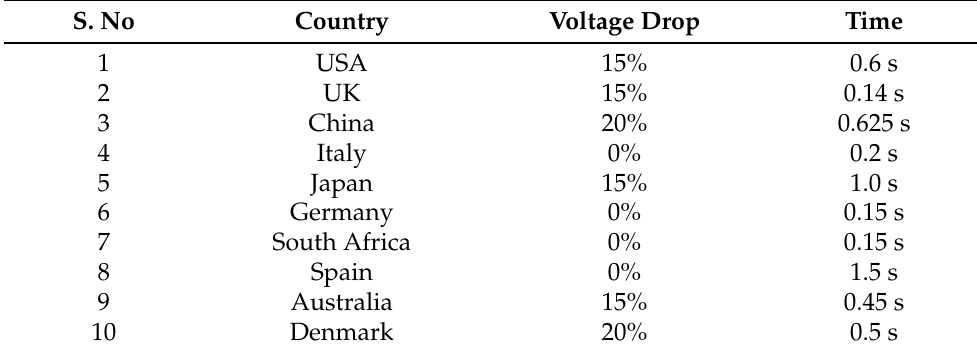
Table 1. The voltage drop and time duration allowed differently based on grid codes in different countries.